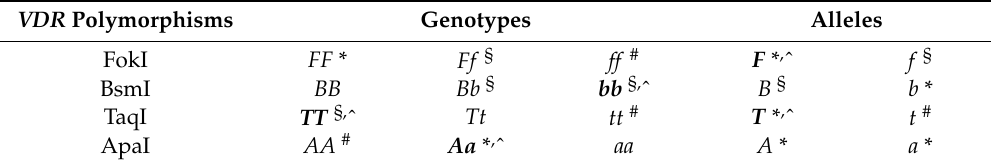
Table 2. Differences in cross-linked C-telopeptides of type II collagen circulating concentrations between patients with osteochondrosis and healthy controls, according to VDR genotypes/alleles. VDR Polymorphisms Genotypes Alleles FokI FF * Ff § ff # F * , ˆ f § BsmI BB Bb § bb §, ˆ B § b * TaqI TT §, ˆ Tt tt # T * , ˆ t # ApaI AA # Aa * , ˆ aa A * a * * p < 0.05 significant higher levels of plasma CTx-II in osteochondrosis patients, § tendency of higher levels of plasma CTx-II in osteochondrosis patients. ˆ risky and # protective genotypes and alleles observed in a larger cohort of Italian subjects [1,2,27] composed by 50 patients with osteochondrosis (with or without hernia or discopathy) and 252 healthy controls. The genotypes and alleles that are significantly relevant for patients with osteochondrosis compared with the healthy controls are indicated in